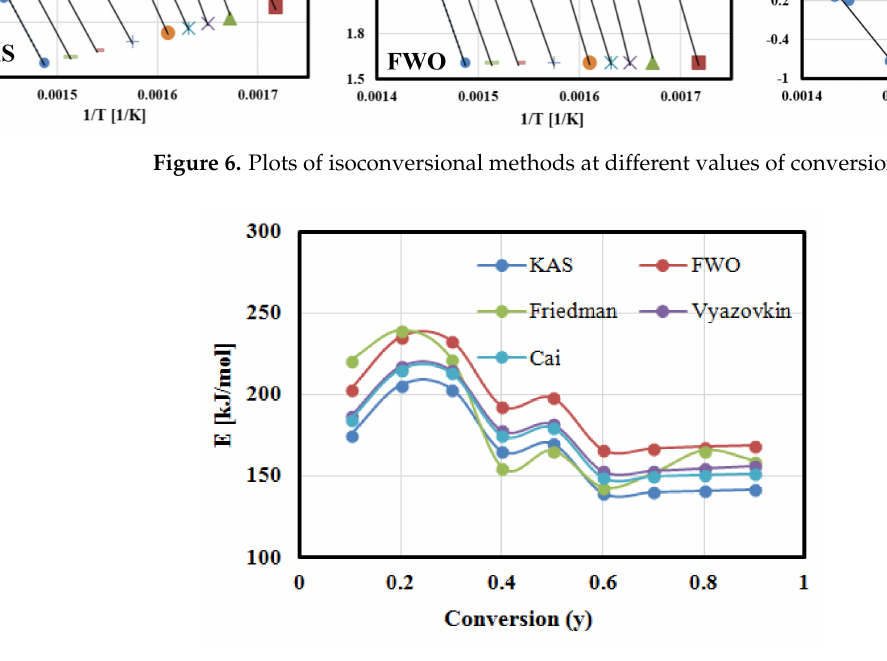
Figure 7. The relationship between apparent activation energy and conversion rates. Table 5. The estimated activation energy at different conversion